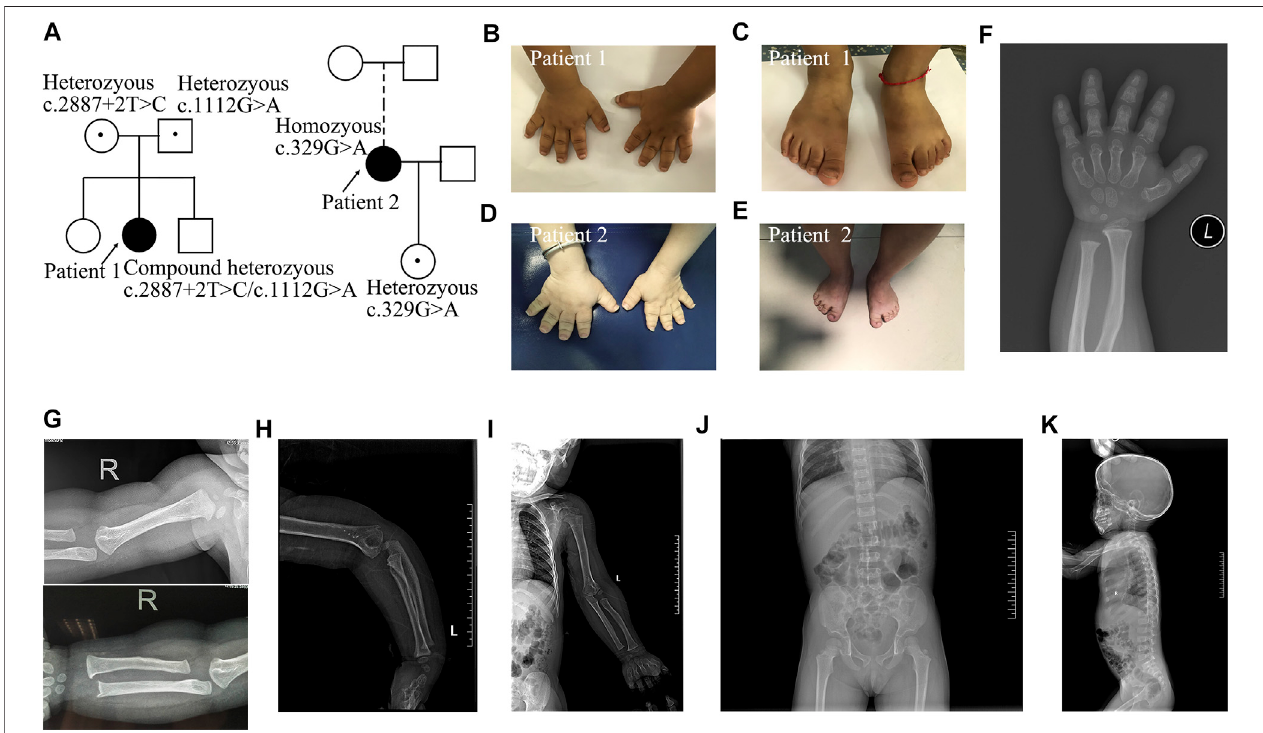
FIGURE 1 | Pedigrees and images of two patients with Acromesomelic Dysplasia Maroteaux Type. (A) Pedigree of two families containing patient 1 and 2; (B,C) smallhandsandfeetinpatient1; (D,E) patient2withlooseandredundantskinon fi ngersandfeet; (F) shortanddysplasticmetacarpalsandphalangesinpatient1; (G-I) The humerus and radius are curved, besides, osteophyte existed in both distal ulna and lateral epicondylar humeri in patient 1. There was no dislocation of the radial head. There were no missing or fused bones; (J,K) Mild scoliosis and irregular anterior wedging of vertebral bodies in patient